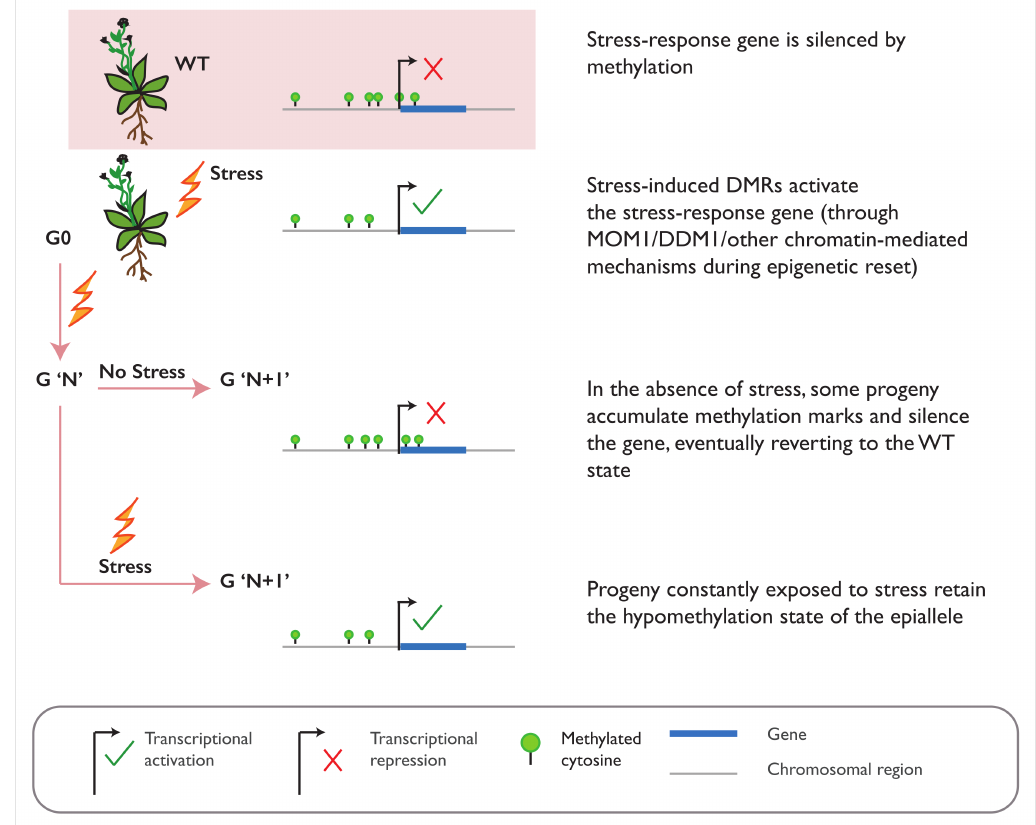
Figure 3. Epiallele formation upon exposure to stress. A stress response gene that is silenced by DNA methylation in wild-type (WT) plants can be activated upon stress exposure by mechanisms that remove the methylation marks. These stress-induced differentially methylated regions (DMRs) may occur immediately in the first generation (G0) but may be heritably carried over only upon repeated exposure to stress (generations G’N’ and G’N+1’). This stress-induced epigenetic memory in the progeny can eventually be released once the stress is alleviated, reverting the epiallele to its WT methylation